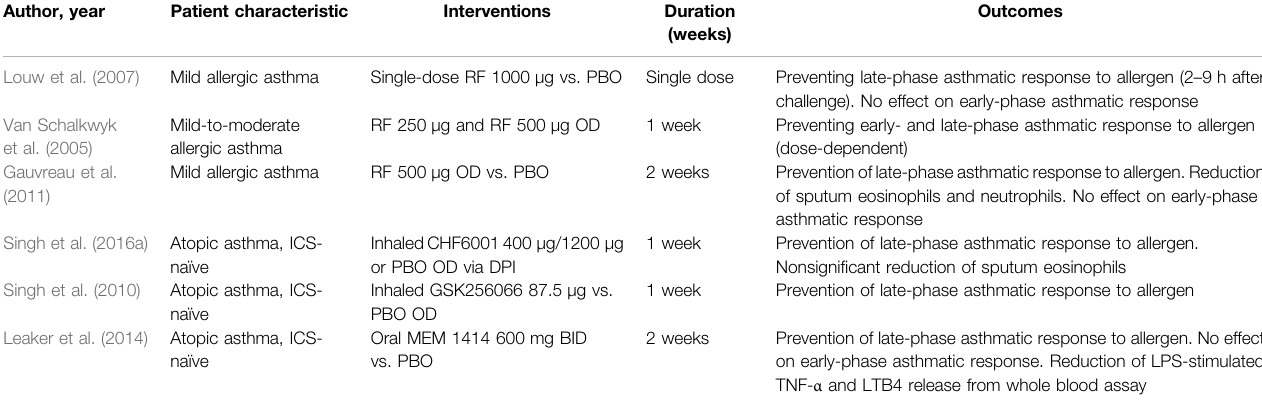
TABLE 2 | Effects of ro fl umilast and the novel PDE4 inhibitor on allergen-induced early and late asthmatic response and airway in fl ammation in asthmatic patients. Author, year Patient